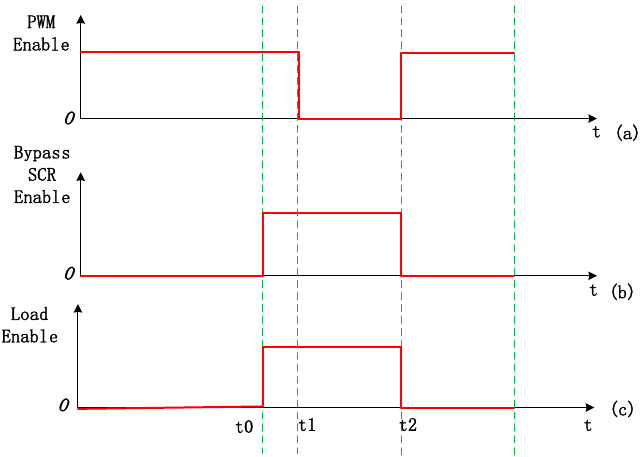
Figure 5. Dynamic switching sequence for impulsive load.